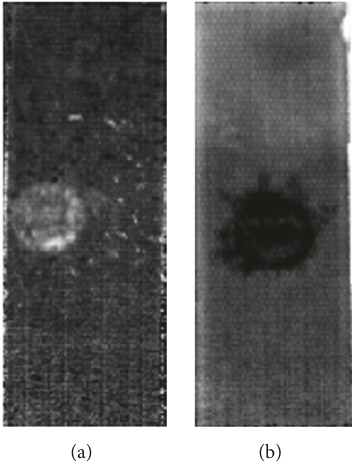
Figure 7: Two specimens’ initial delamination position; (a) side delamination; (b) central